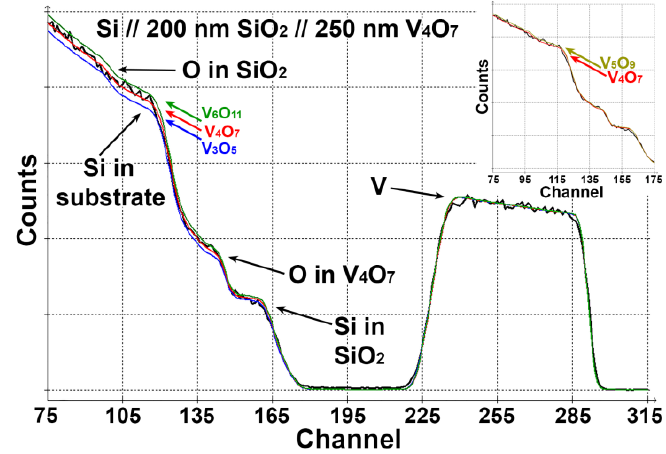
Figure 2. RBS of V 4 O 7 film. Three color lines correspond to fits for films with different stoichiometry. Inset shows the comparison between experiment and simulation for V 4 O 7 and V 5 O 9 . 1 channel = 3.94 keV.